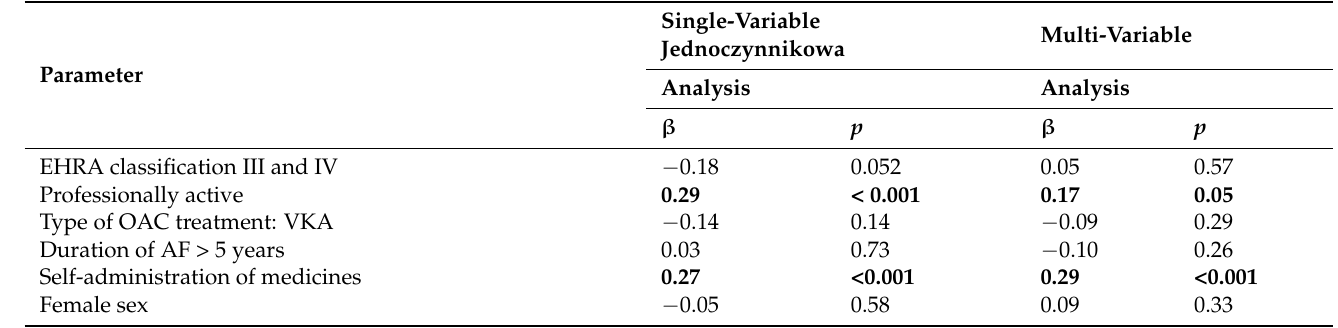
Table 3. Single- and multi-variable analysis PACT-Q2 convenience domain of the study group ( n =